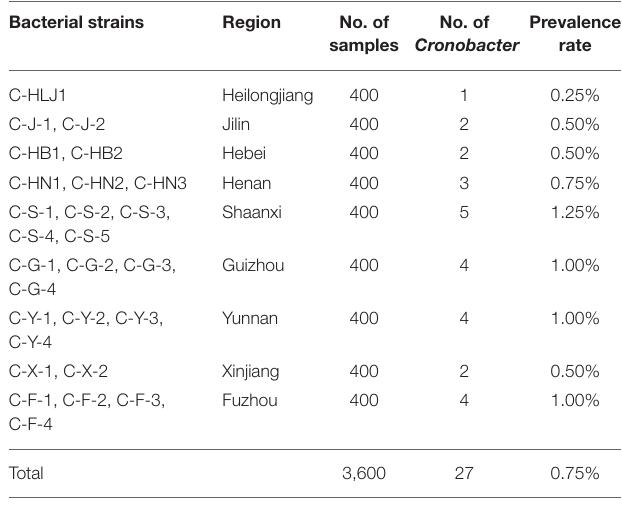
TABLE 1 | Prevalence of Cronobacter spp. in commercial PIF from nine provinces in China. Bacterial